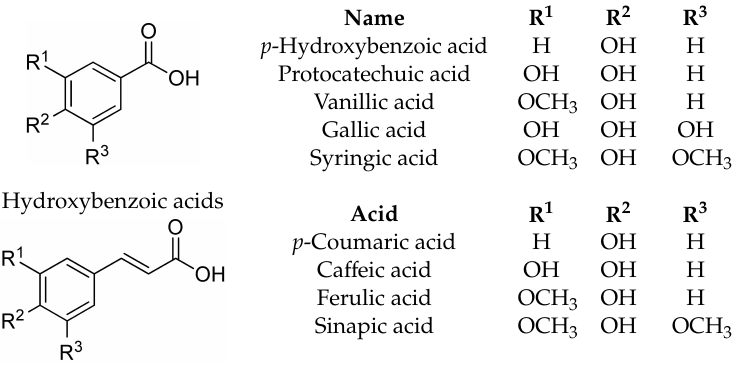
Table 1. Structure and classification of phenolic